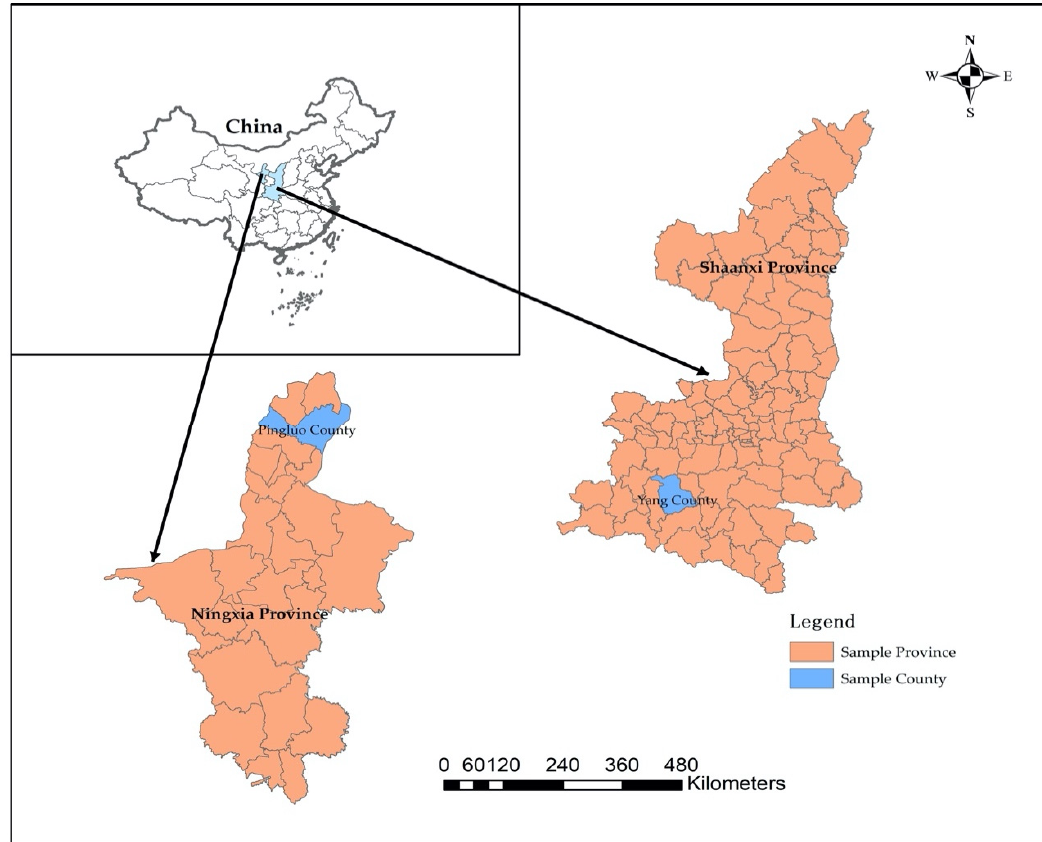
Figure 2. The location of the investigated area in this